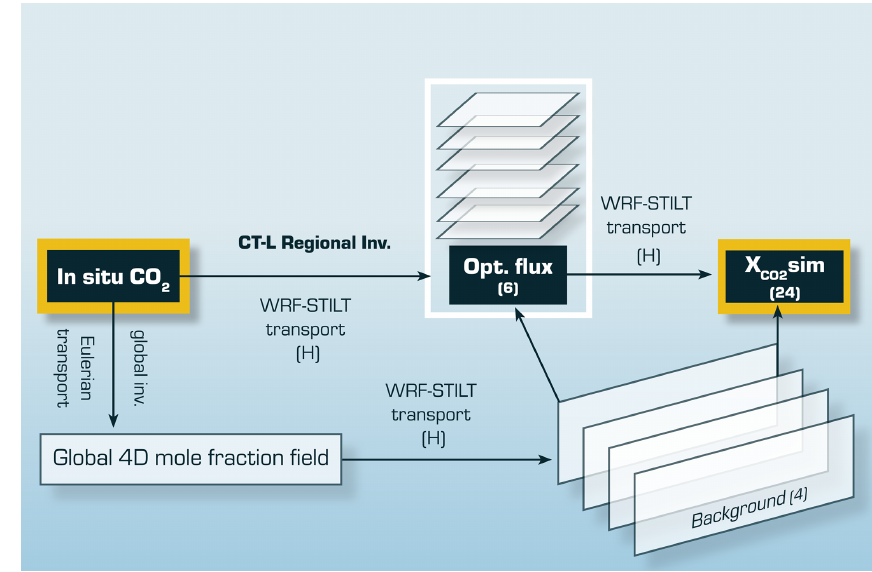
Figure 1. Flowchart linking in situ measurements of CO 2 to simulated